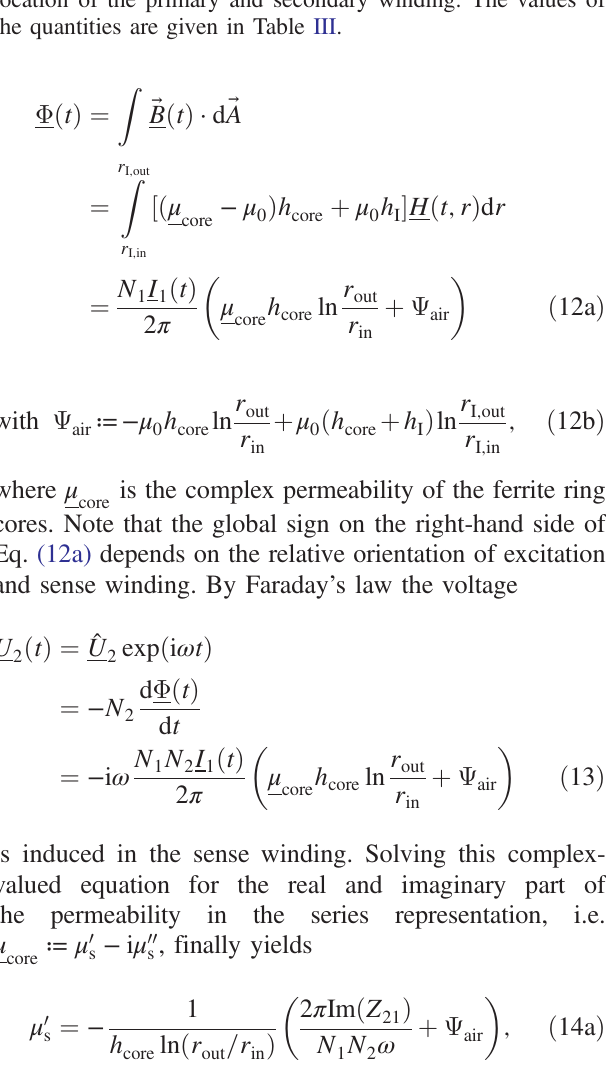
TABLE III. Geometric quantities related to the location of the primary and secondary winding. The quantities are illustrated in Fig. 6. Quantity